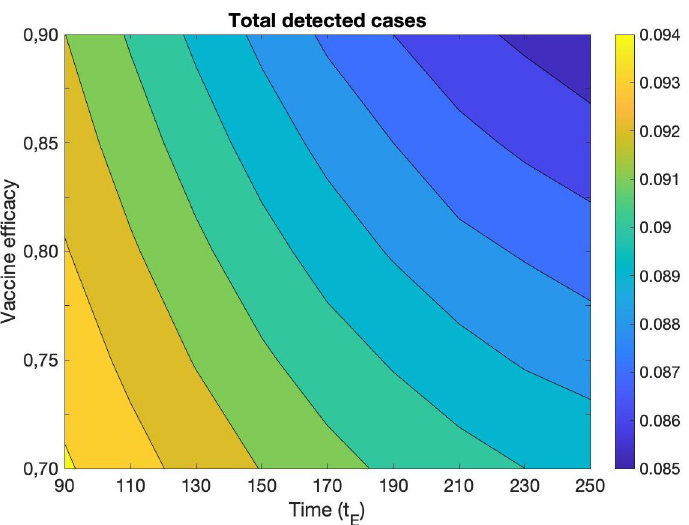
Fig 4. Total number of detected cases at the final day of simulation (December 16, 2021) as a function of the maximum efficacy of full vaccination, e 1 + e 2 , and the medium time of antibody decay, t E .